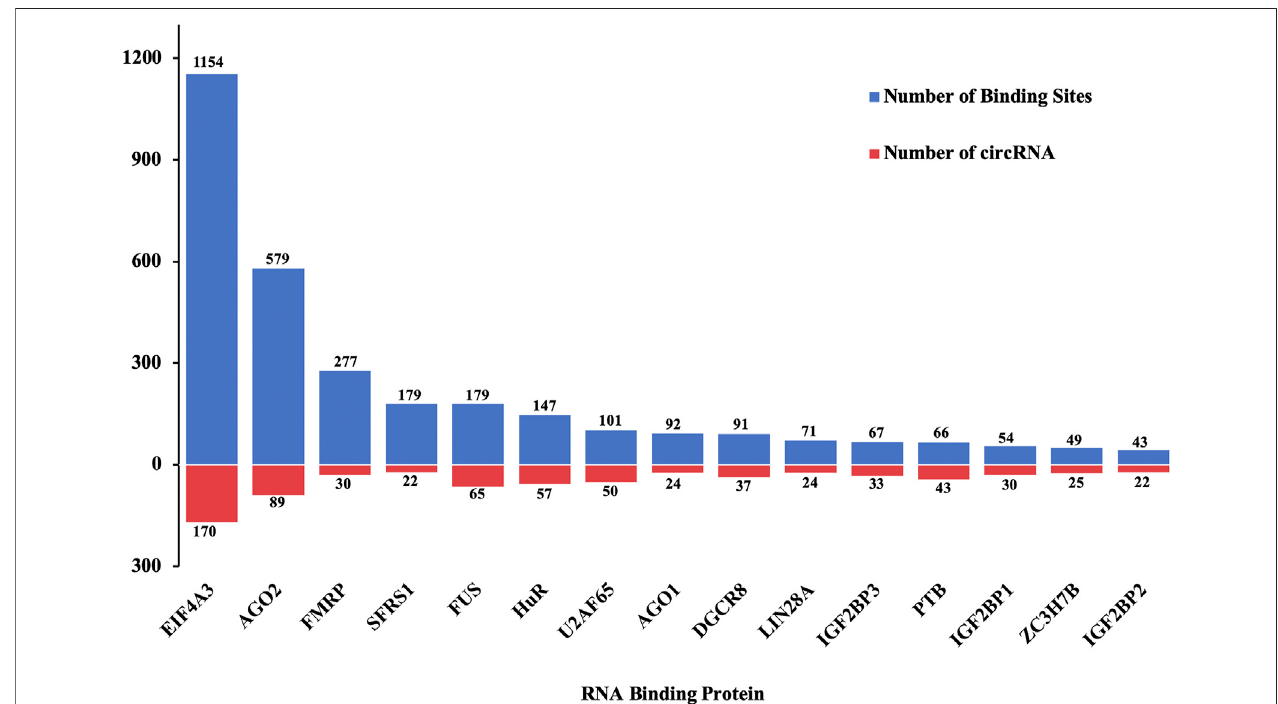
FIGURE 8 | Distribution of top 15 RBPs predicted to bind to differentially quanti fi ed circRNAs.